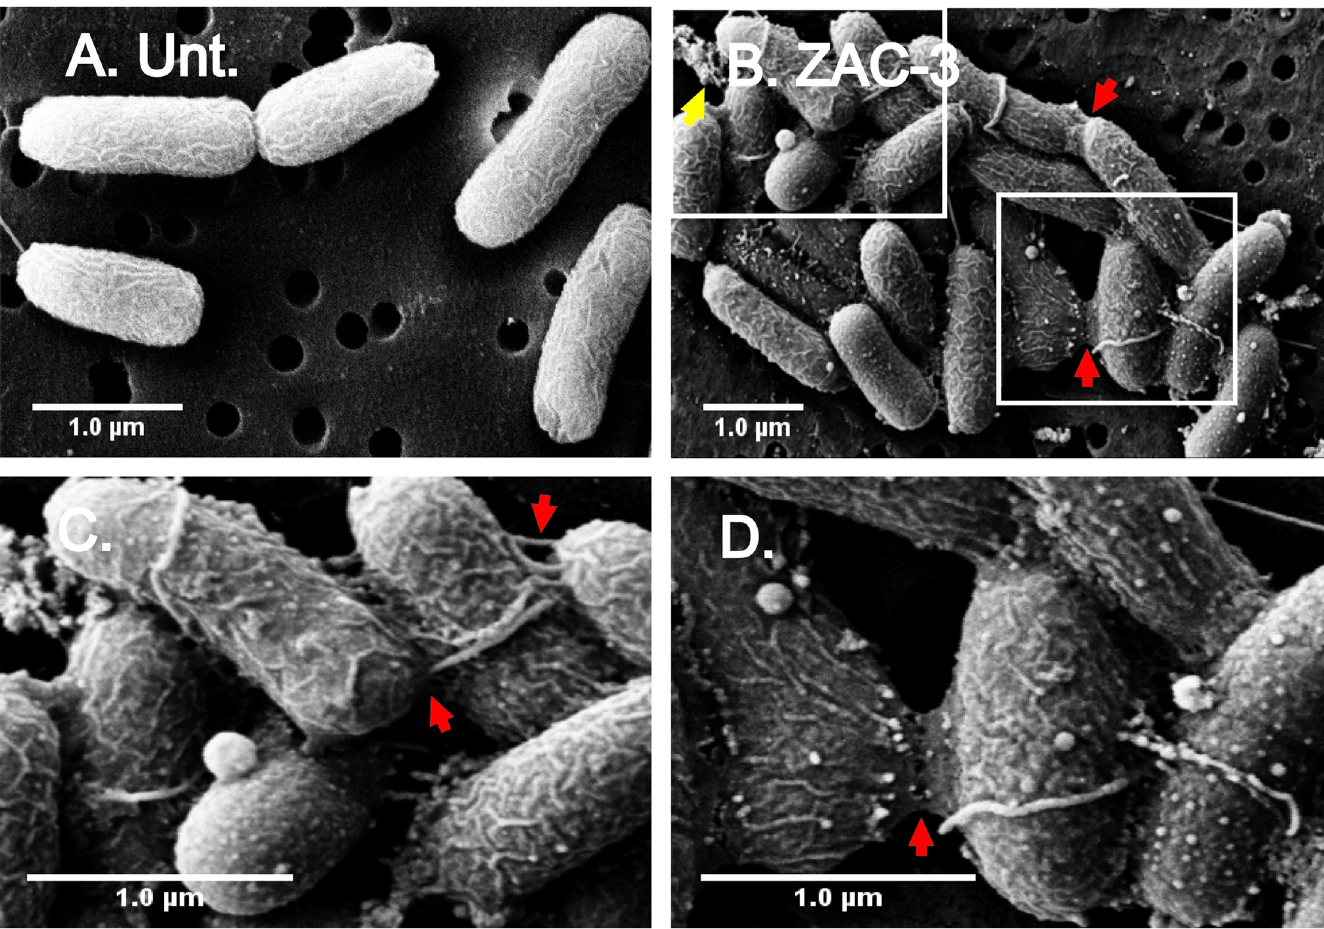
Fig 3. SEM analysis of V . cholerae following treatment with ZAC-3 IgG. SEM images of V . cholerae O395 treated with (A) medium control, or (B) ZAC-3 IgG (9 μ g/ mL) for 1 h. The insets in Panel B are shown as panels C and D. Highlighted is evidence of extracellular debris (yellow arrows; panels B) and web-like extensions between cells (red arrows; panels B-D). Scale bars, 1 μ